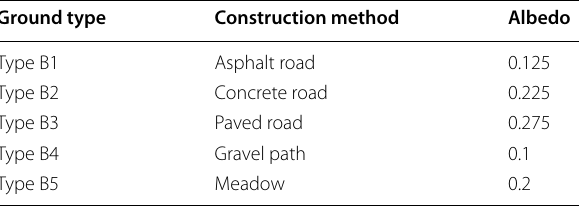
Table 4 Assumptions of the albedo of the five ground surfaces used within the one-dimensional model calculations